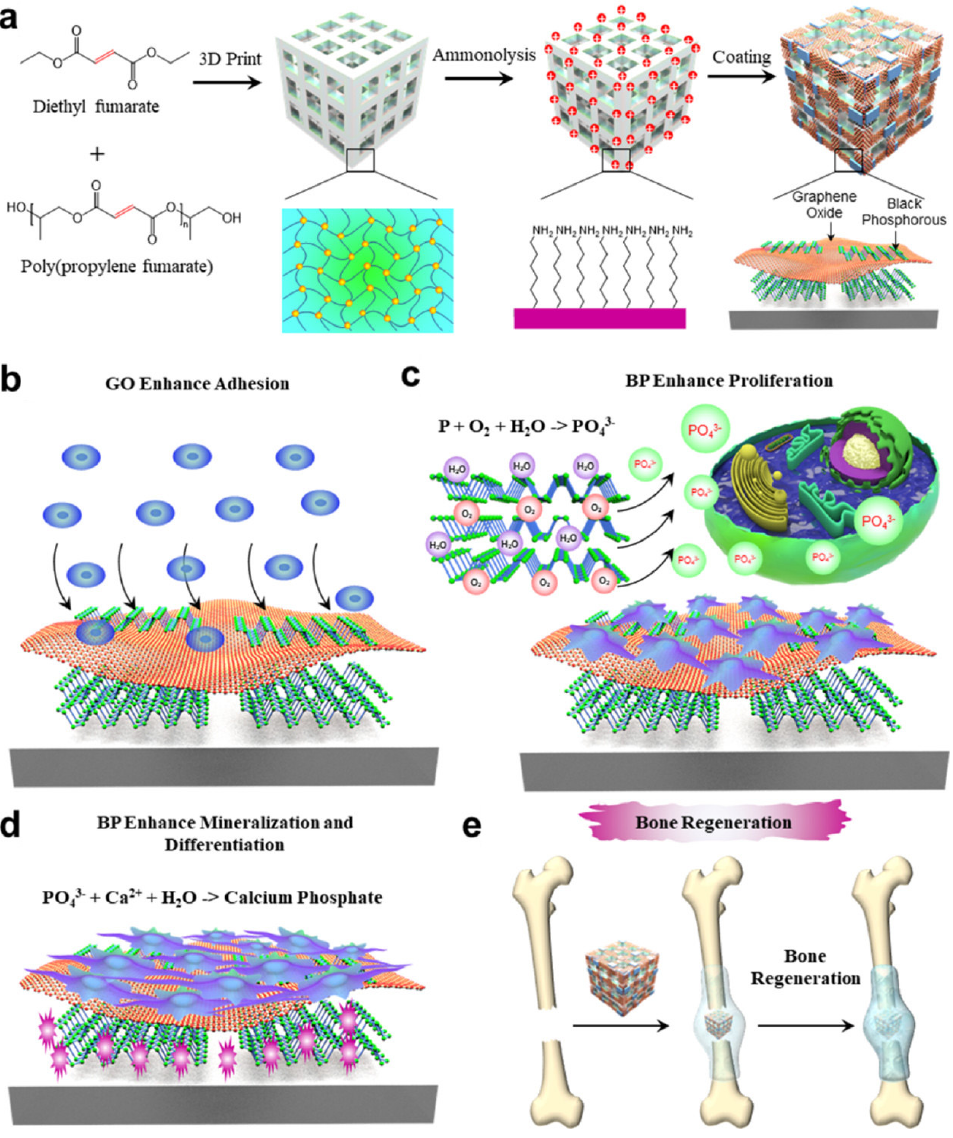
that the hydrogel scaffold promoted early nerve regeneration and angiogenesis. This was beneficial for the rapid repair of bone tissue. Wang et al. developed a microfluidic scaffold based on BP with reversible heat-responsive contraction and expansion behaviors (Figure 5b) [105]. Under the photothermal effect generated by BP, N-isopropylacrylamide in the scaffold underwent a temperature-induced volumetric phase transition. This triggered reversible contraction and expansion behaviors to promote the entry of the suspension cells into the scaffold. The vascular regeneration ability of the scaffolds was investigated. The photothermal response behavior of the scaffold promoted the growth of vascular endothelial cells in the scaffold. This was conducive to vascularized bone regeneration.